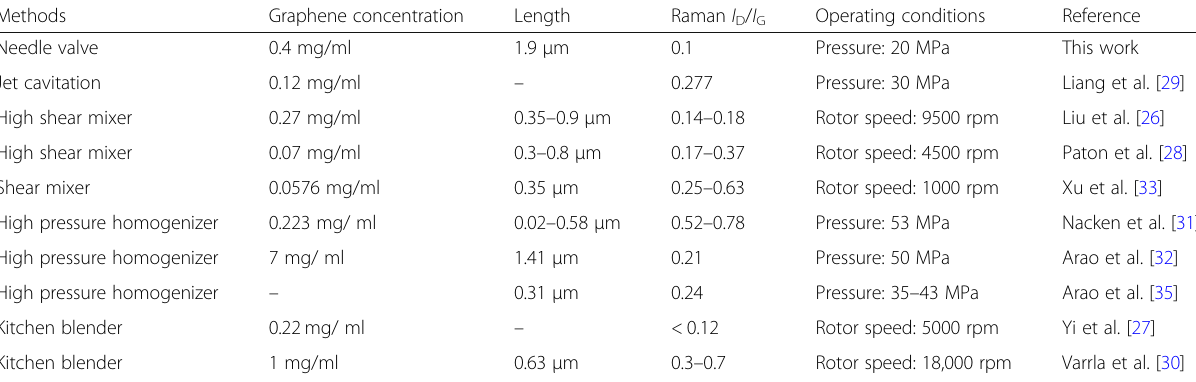
Table 1 A summary of the concentration, length, and I D / I G of the few-layer graphene produced by different fluid dynamics